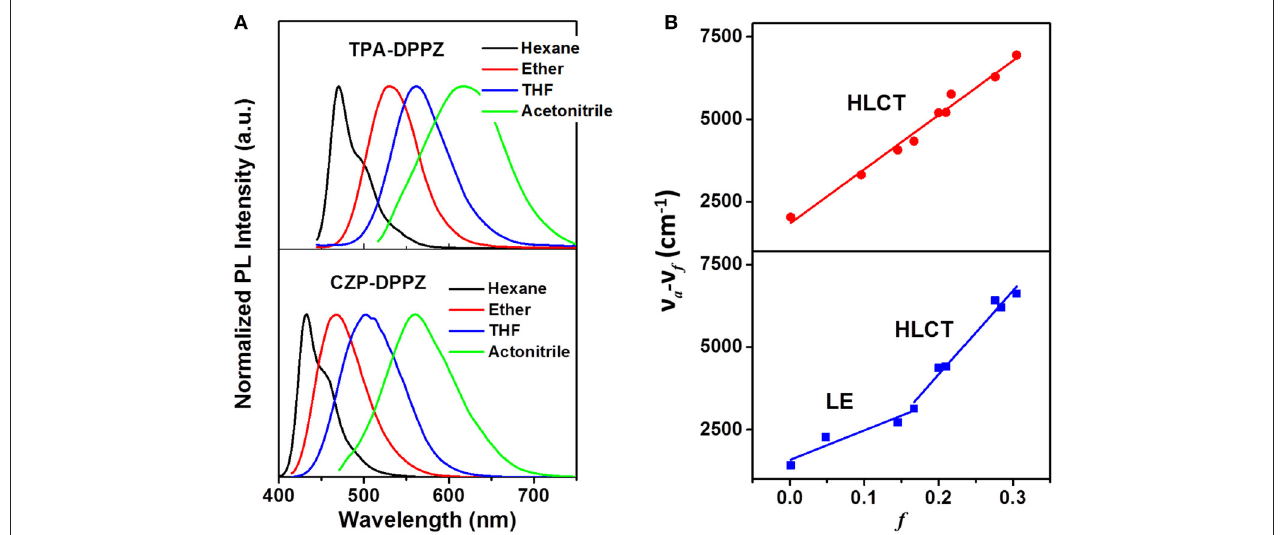
FIGURE 4 | (A) Solvent effect on the PL spectra of CZP-DPPZ, TPA-DPPZ and PXZ-DPPZ, in which the polarity f of the four solvents are f hexane = 0.0012, f ether = 0.167, f